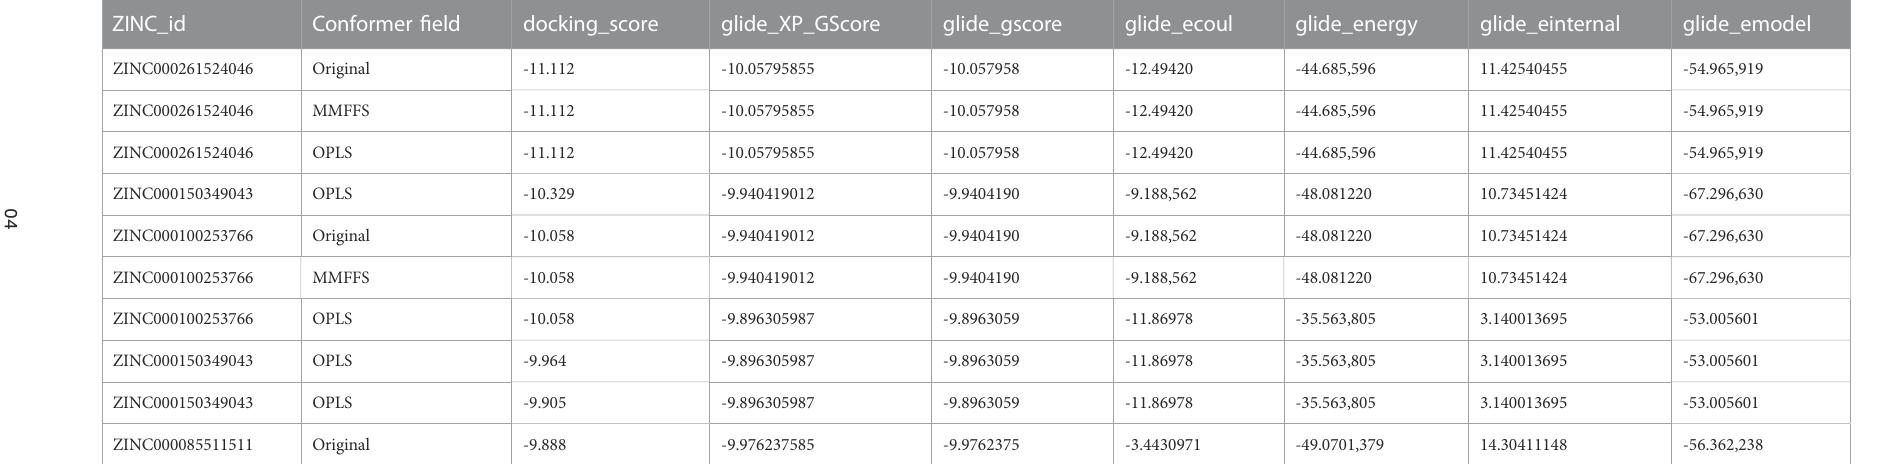
TABLE 1 The top 10 ligands after the virtual screening. A library of 307,814 natural compounds of biological origin (a total 481,799 structures) has been used as a screen